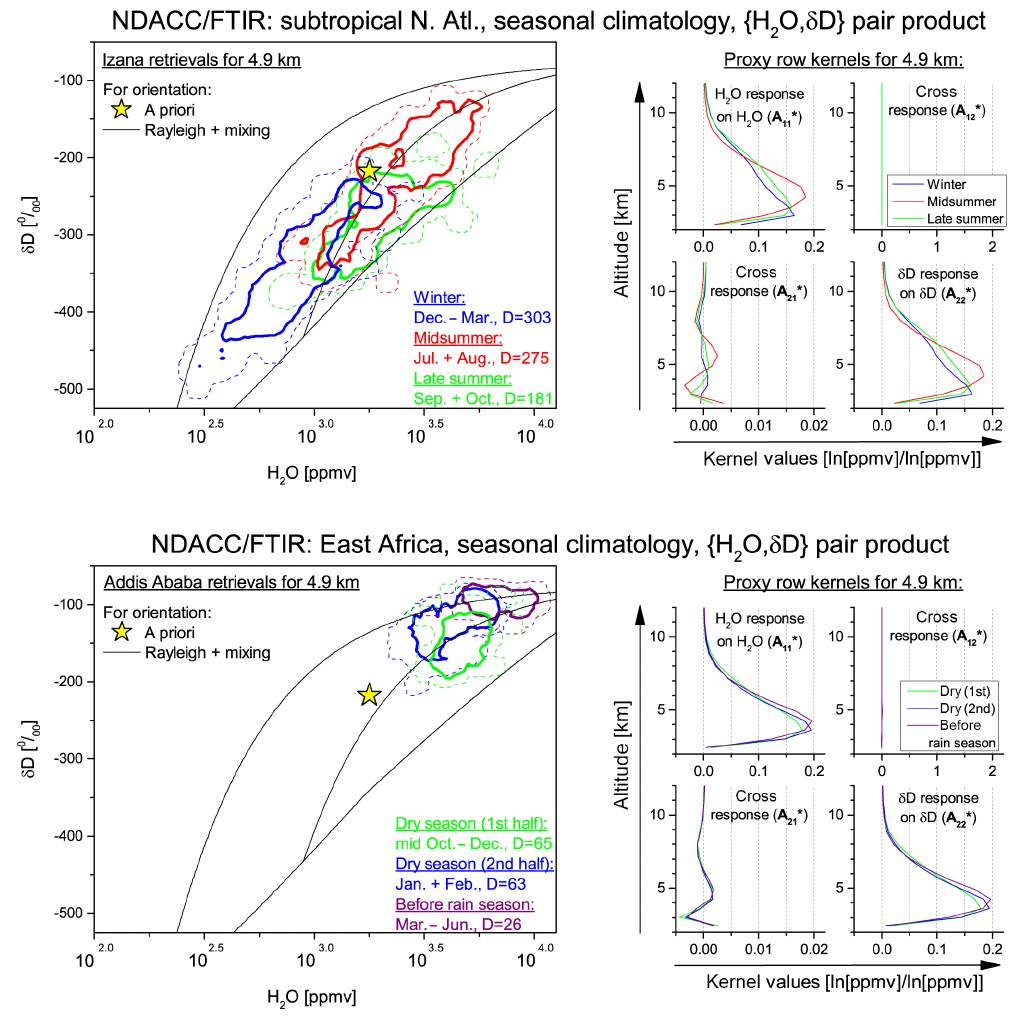
Figure 8. Example of seasonal {H 2 O, δ D} pair distribution climatologies obtained from FTIR retrievals for 4.9km at Izaña/Tenerife (top panels) and Addis Ababa (bottom panels). The left panels show the distribution density plots, whereby the thin dashed and thick solid lines mark the areas that include 95 and 66% of all data, respectively. The different colours correspond to the seasons as explained in the legends. The yellow star and black lines are the a priori and the simulated lines as in Figs. 5 and 6. The right panels show corresponding typical row kernels for 4.9km for the H 2 O and δ D proxies as well as for their cross-responses (for more general details about the FTIR kernels, see Fig. 1 and corresponding